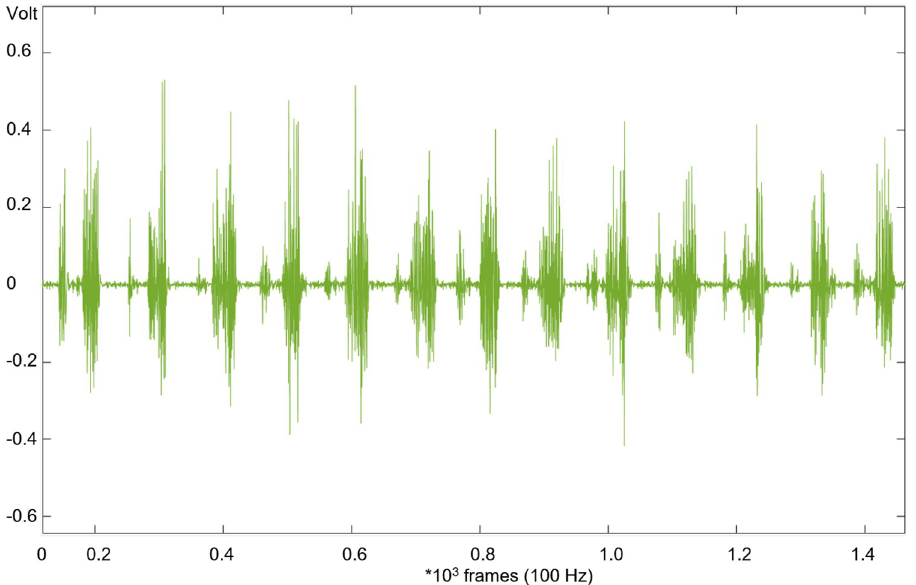
Fig 1. Example of a raw sEMG signal of the gastrocnemius